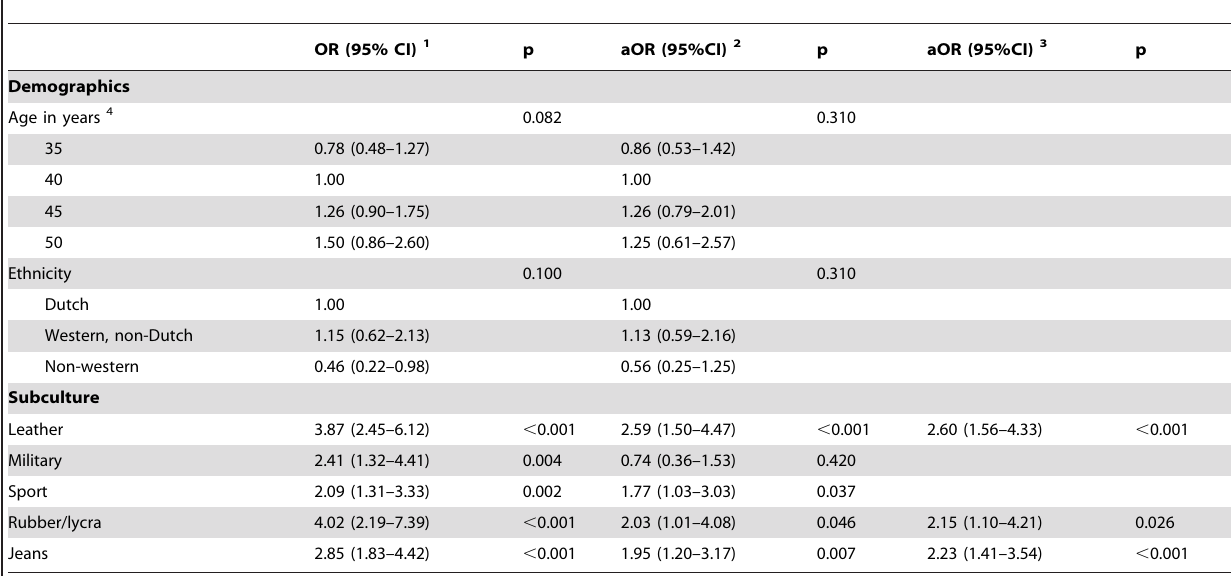
Table 3. Identifiable determinants of hepatitis C seropositive status among 786 HIV-infected men who have sex with men, of whom 93 were hepatitis C seropositive, in Amsterdam, 2008–2009.